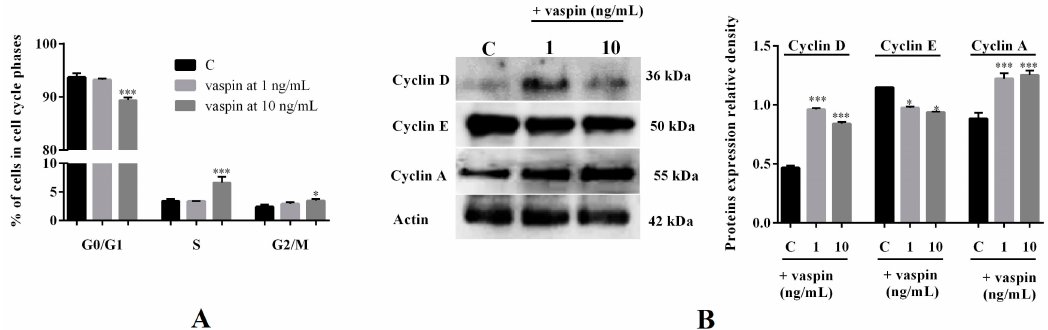
Figure 2. E ff ect of vaspin on granulosa cell cycle regulation: Cells were treated with vaspin at doses of 1 and 10 ng / mL for 24 h, after which the percentage of Gc in each phase of the cell cycle was measured using flow cytometry ( A ) and the evaluation of cyclins D, E, and A protein expression using Western blot were normalized to the actin levels (full gel images available in the Supplementary Materials) ( B ). Experiments were independently performed and repeated four times ( n = 4). The data are plotted as the mean ± SEM. Significant di ff erences between control and vaspin treated cells is indicated by * p < 0.05, *** p < 0.001; Control